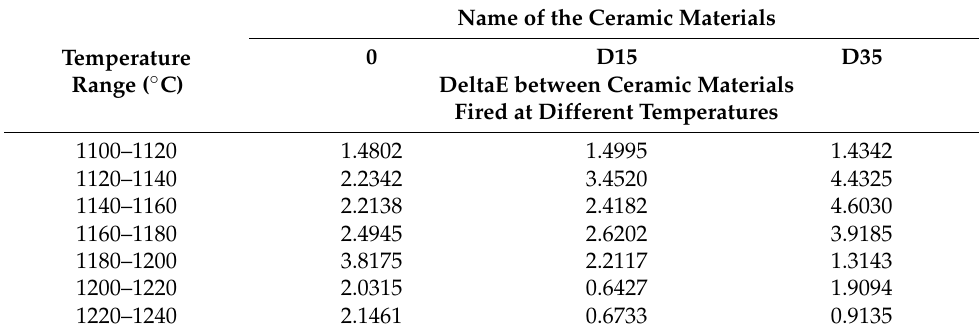
Table 4. DeltaE between obtained ceramic materials fired at different temperatures.